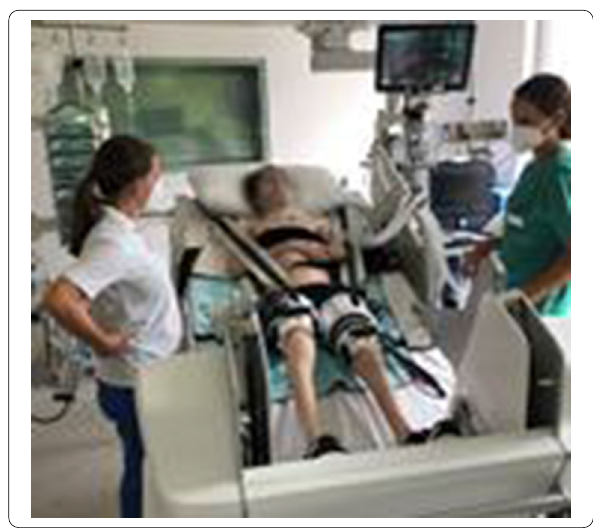
Figure 1: VEMO therapy with a ventilated patient after double lung transplantation.